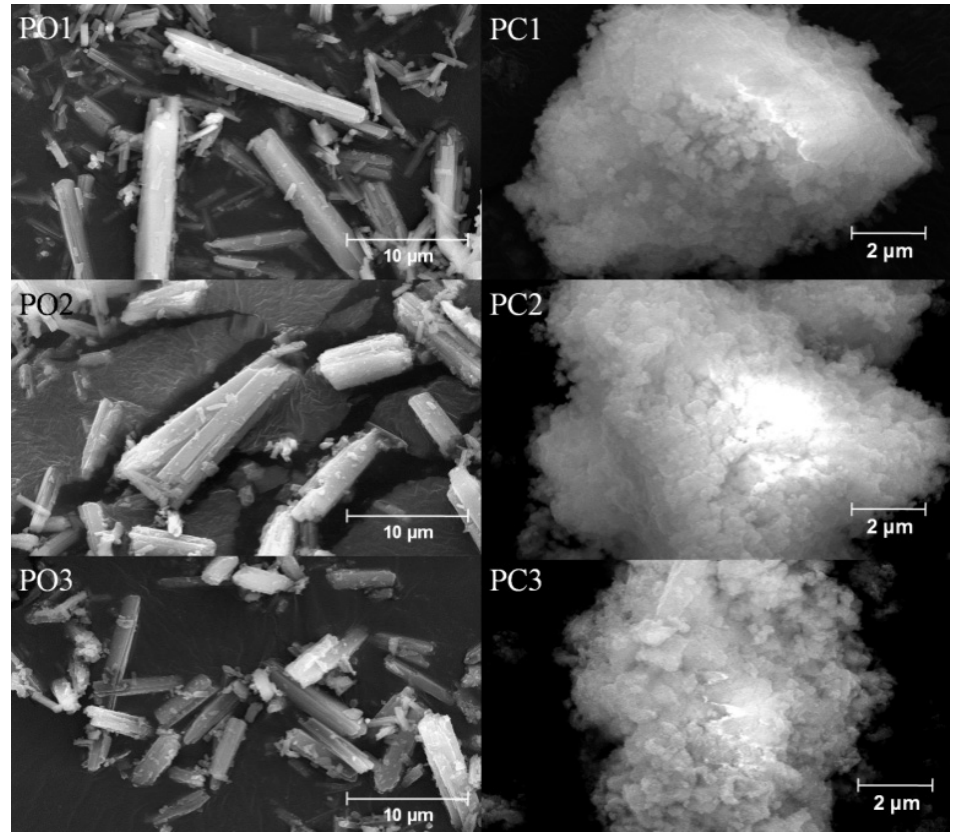
Figure 7. Morphologies of precursors.